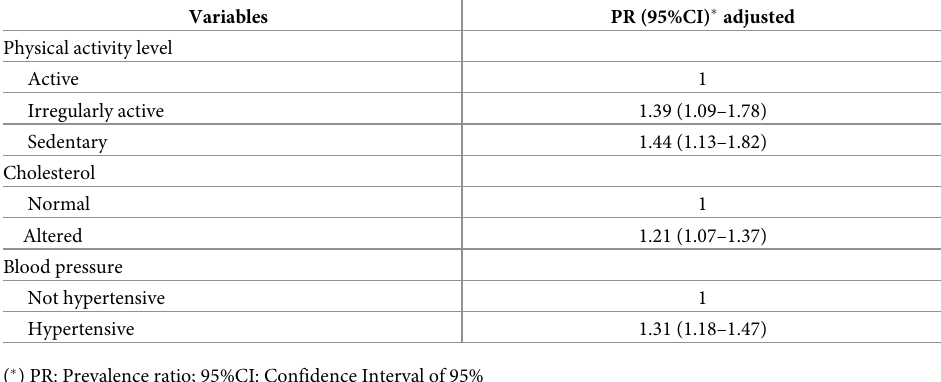
Table 4. Factors associated with abdominal obesity in climacteric